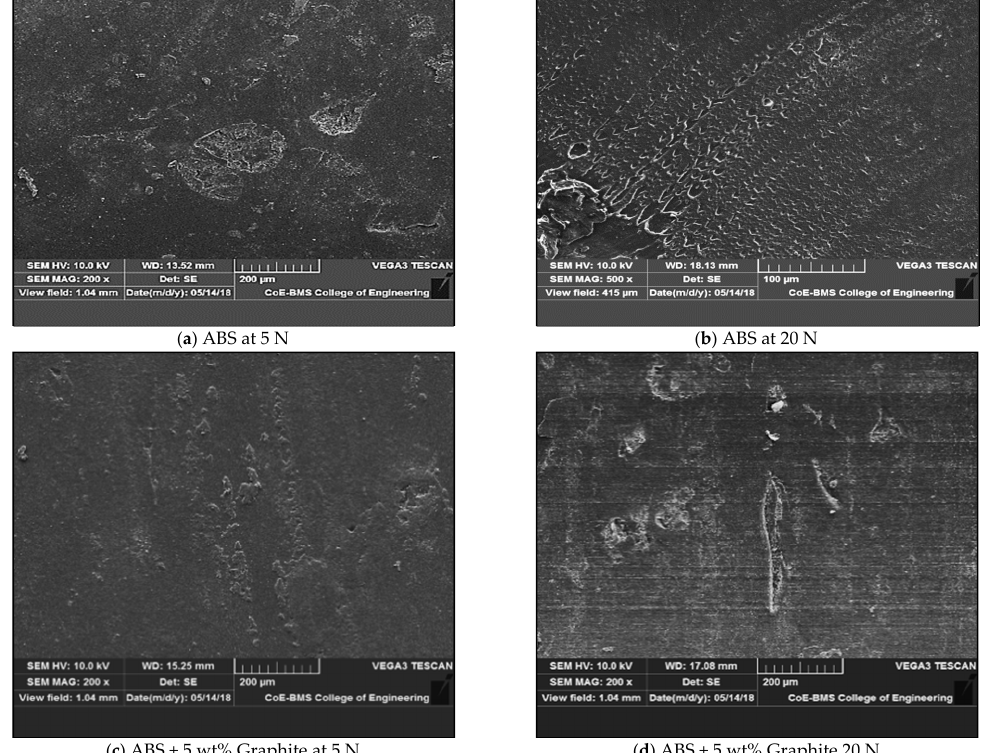
Figure 7. Scanning electron micrographs of the wear test specimens showing the morphology the worn out surfaces after the friction and wear test at different loads. ( a ) ABS at 5 N; ( b ) ABS at 20 N; ( c ) ABS + 5 wt% graphite at 5 N; ( d ) ABS + 5 wt% graphite 20 N.